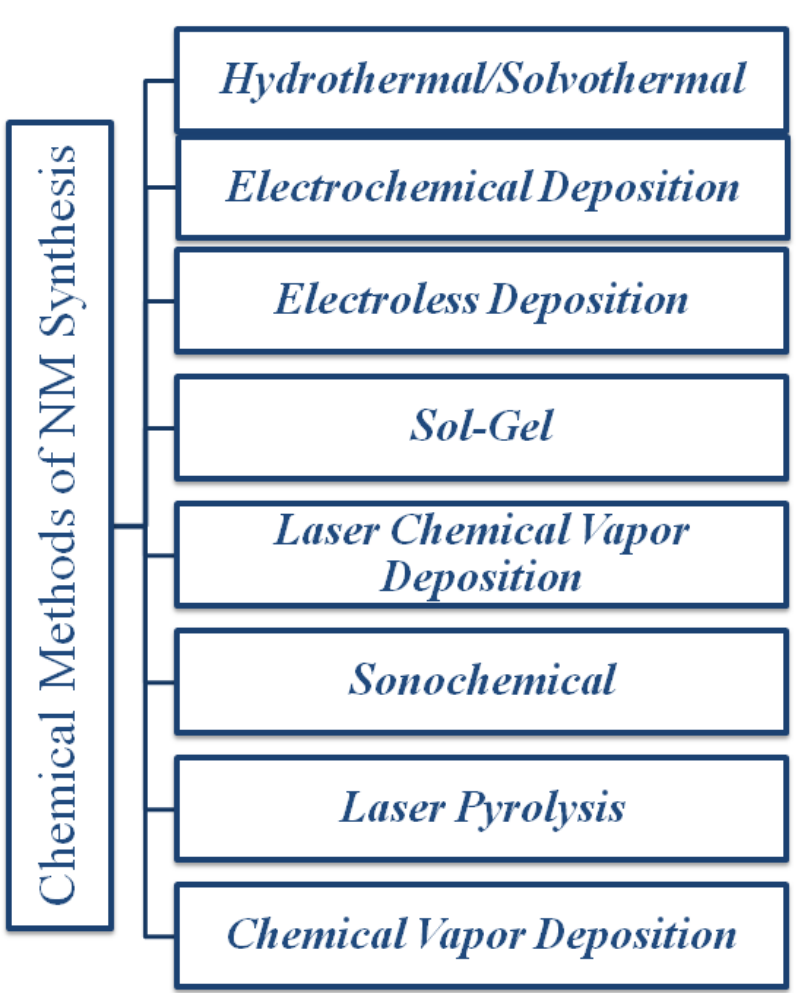
Figure 5. Chemical methods of synthesis of nanomaterials.